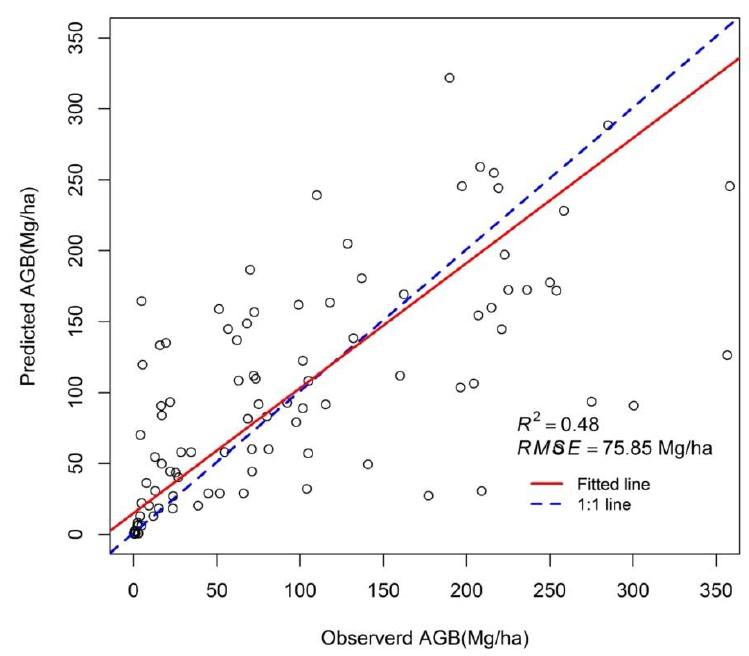
Figure 5. The validation of mangrove biomass estimated model. R 2 represents the adjusted coefficient of determination, RMSE represents the root-mean-square error.